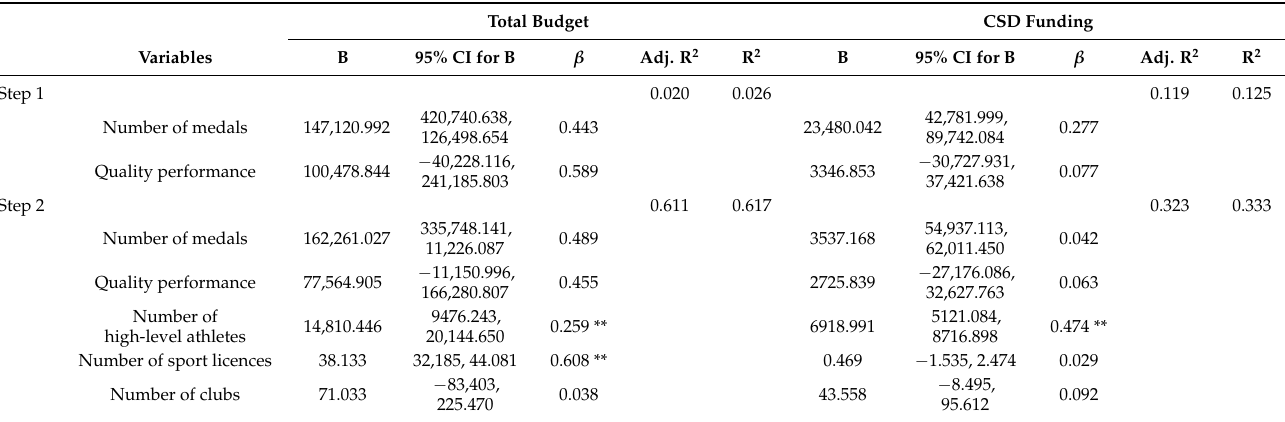
Table 4. Multiple regression model of predictors associated with the financing of Olympic sport